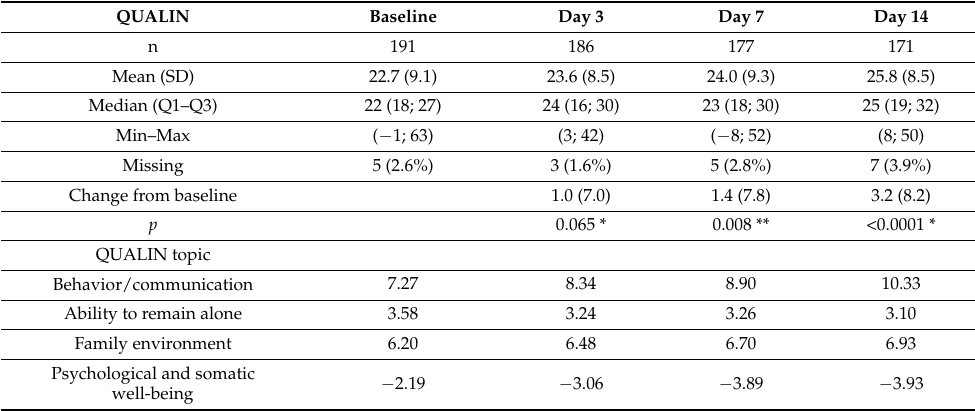
Table 8. Evolution of the QUALIN score per time